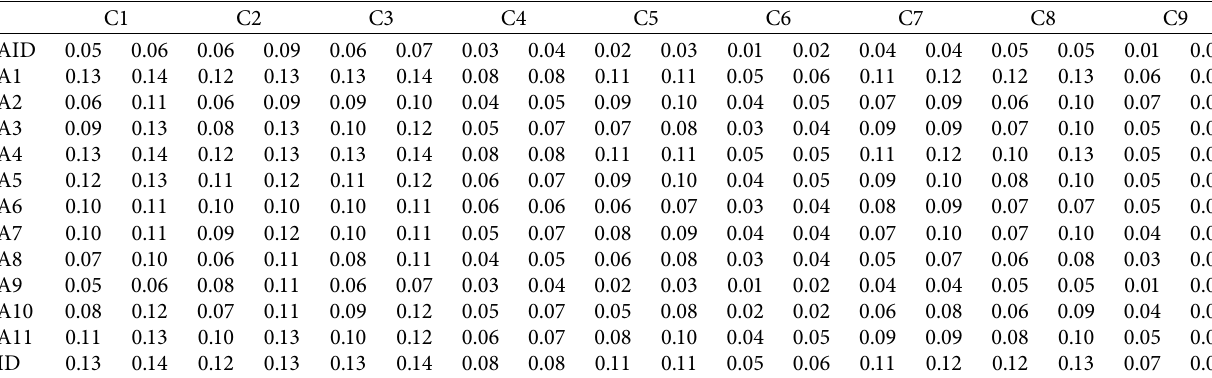
Table 12: Rough weighted normalized